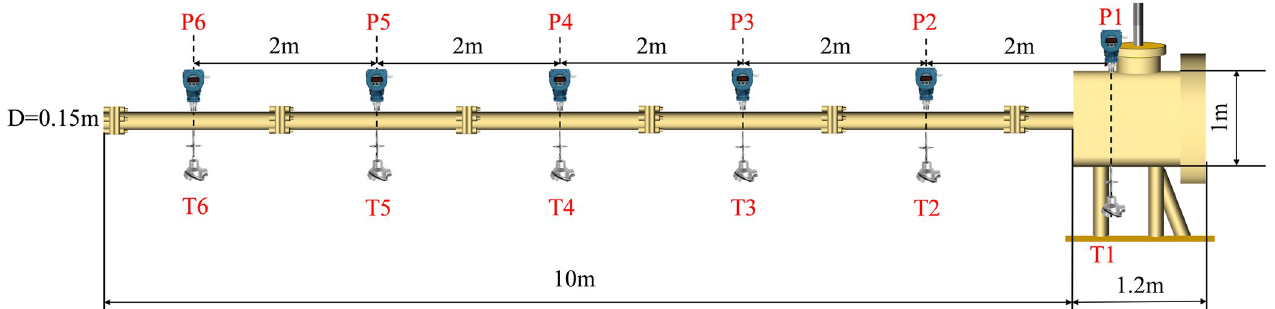
Fig 3. The testing platform of the tube gas explosion: Schematic diagram of experimental